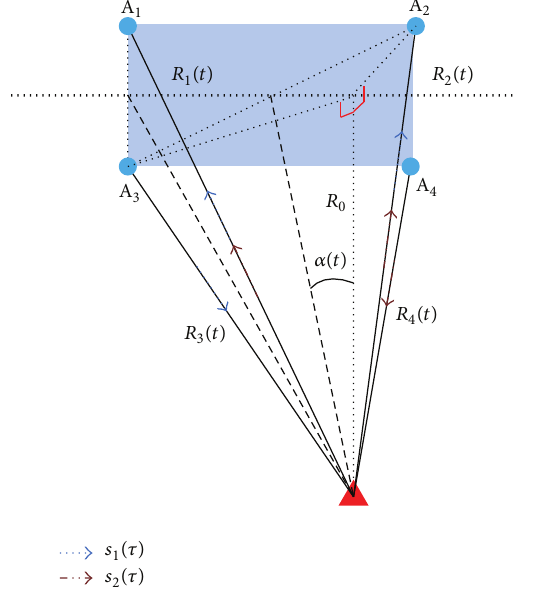
Figure 7: Geometry of equivalent beam phase centers.